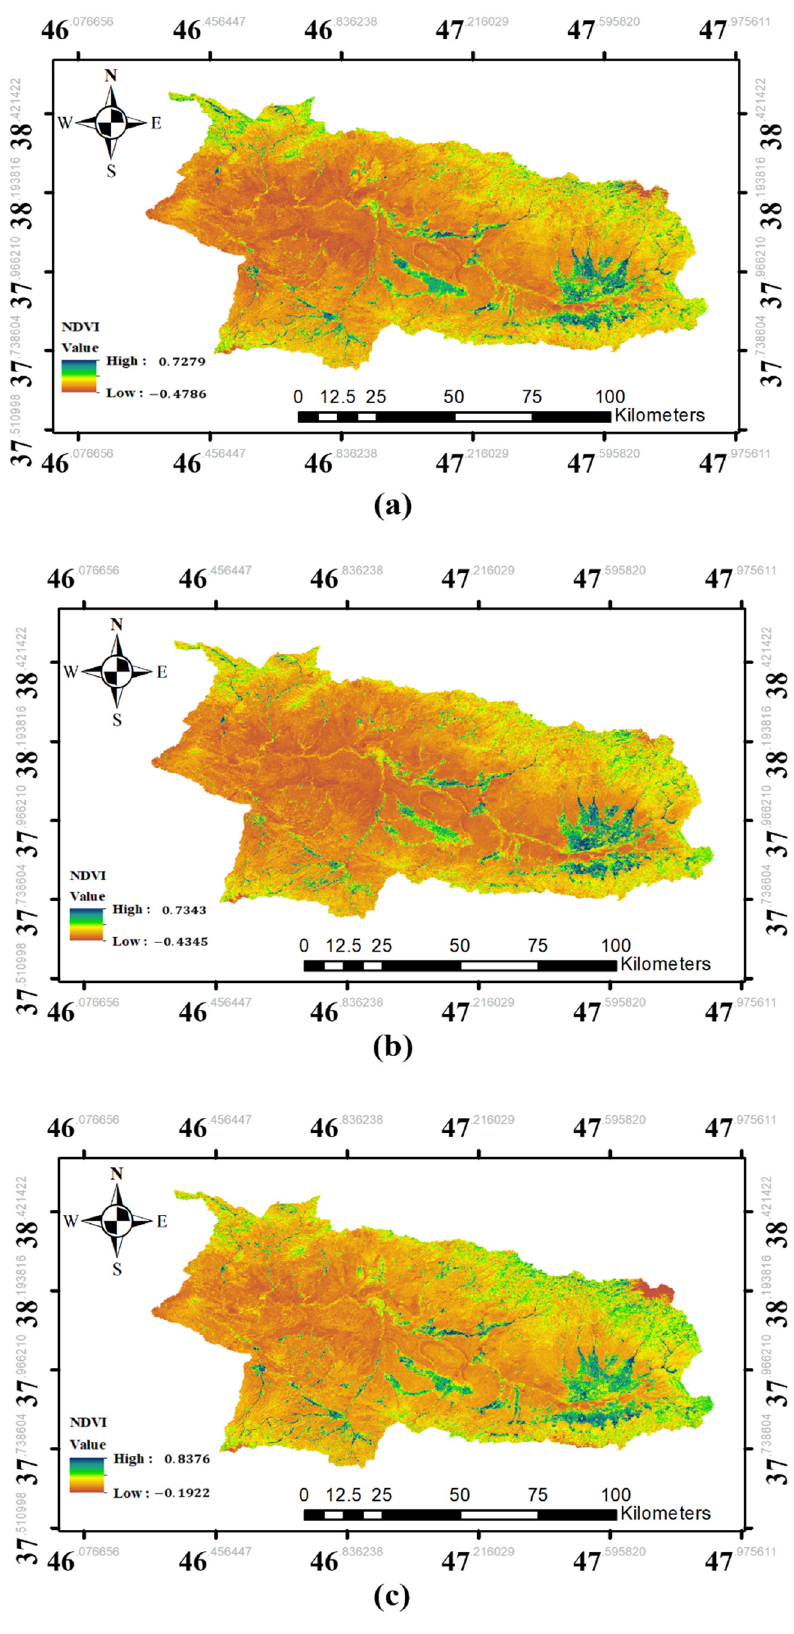
Figure 8. The average NDVI maps over the AC watershed for ( a ) 1990–2000, ( b ) 2000–2010, ( c ) 2010–2020.